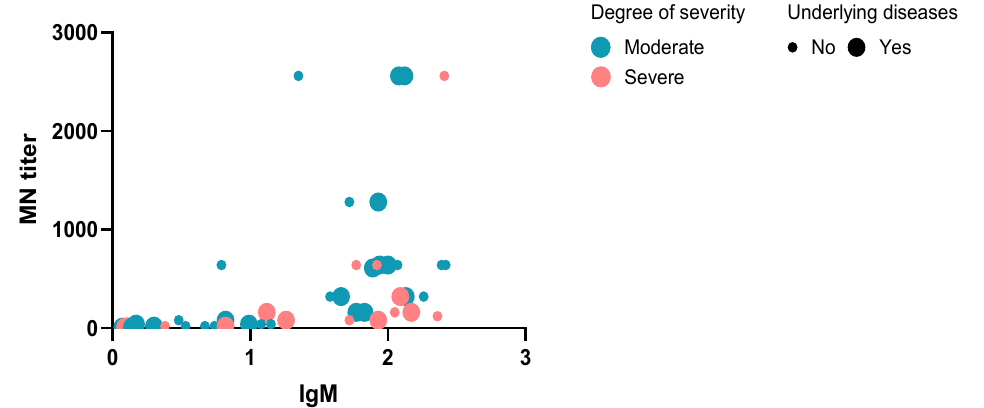
Figure 3. Bubble plot MN titers versus IgM antibodies according to the degree of severity and underlying diseases status.